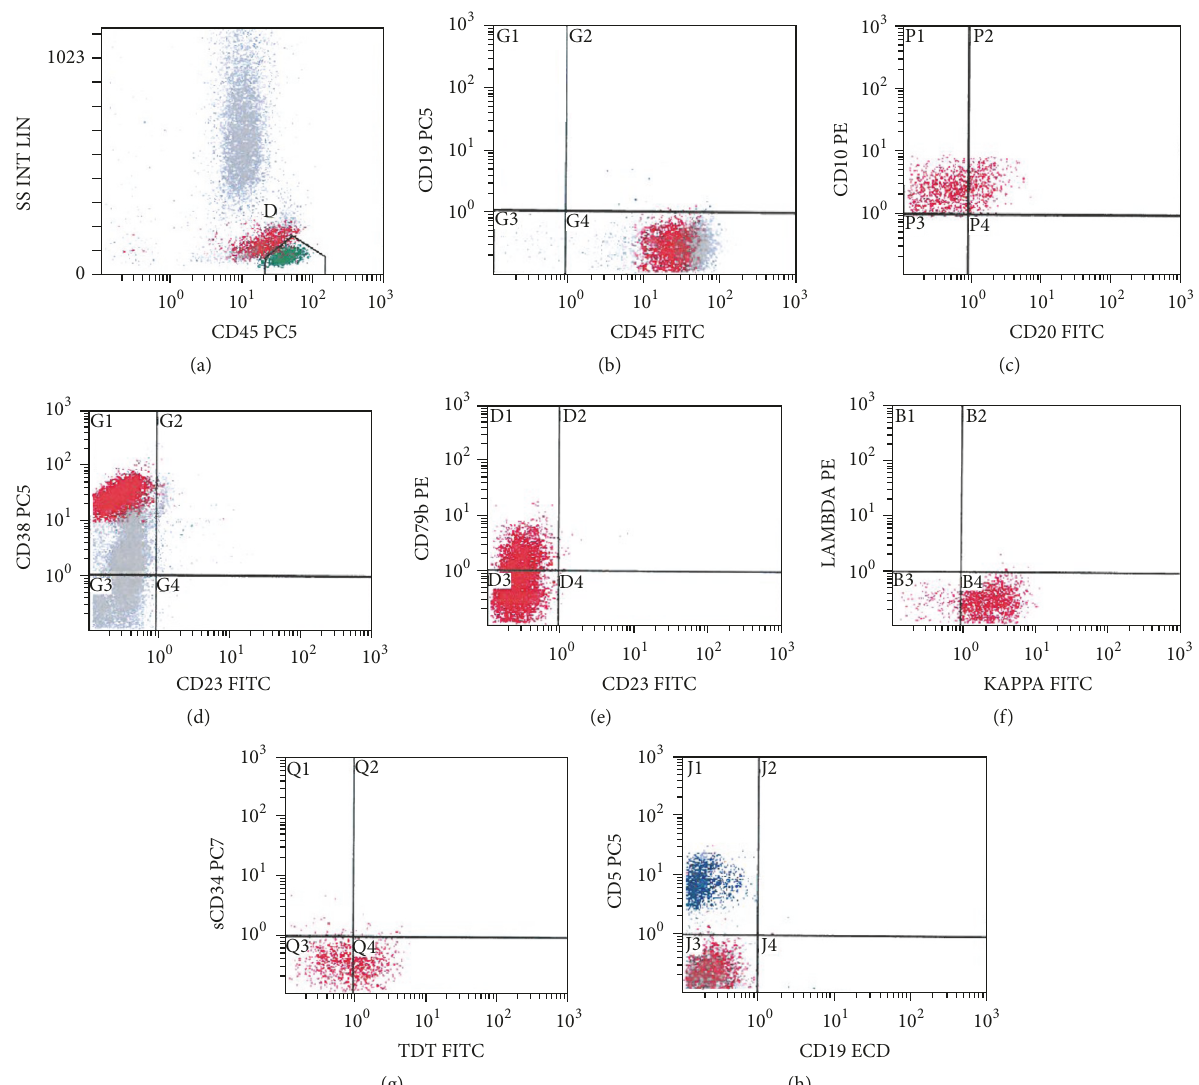
Figure 5: Flow cytometry on bone marrow aspirate: a population of monotypic B-cells, expressing CD45, CD10, CD38, and surface kappa light chain restriction. The monotypic B-cells are negative for CD 5 with downregulation of pan B markers (partial CD79 (dim), loss of CD19 and CD20).